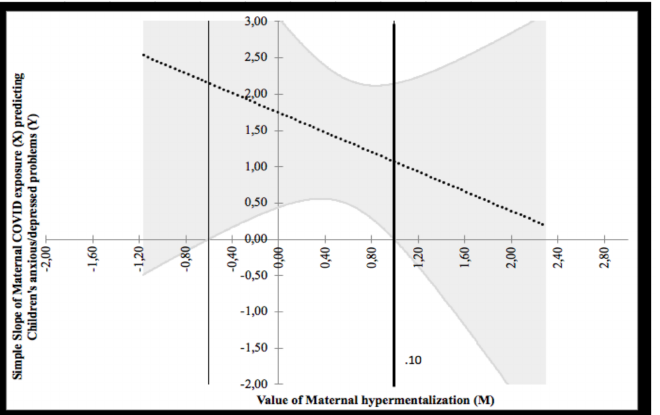
Figure 3. Probing interaction with the Johnson–Neyman technique for the COVID-19 exposure pre- dictor and the maternal hypermentalization moderator on children’s anxious/depressed problems.